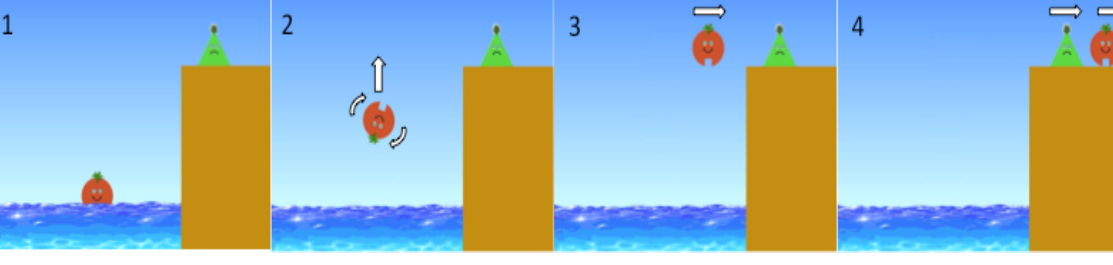
Figure 1. An example of the stimuli shown to